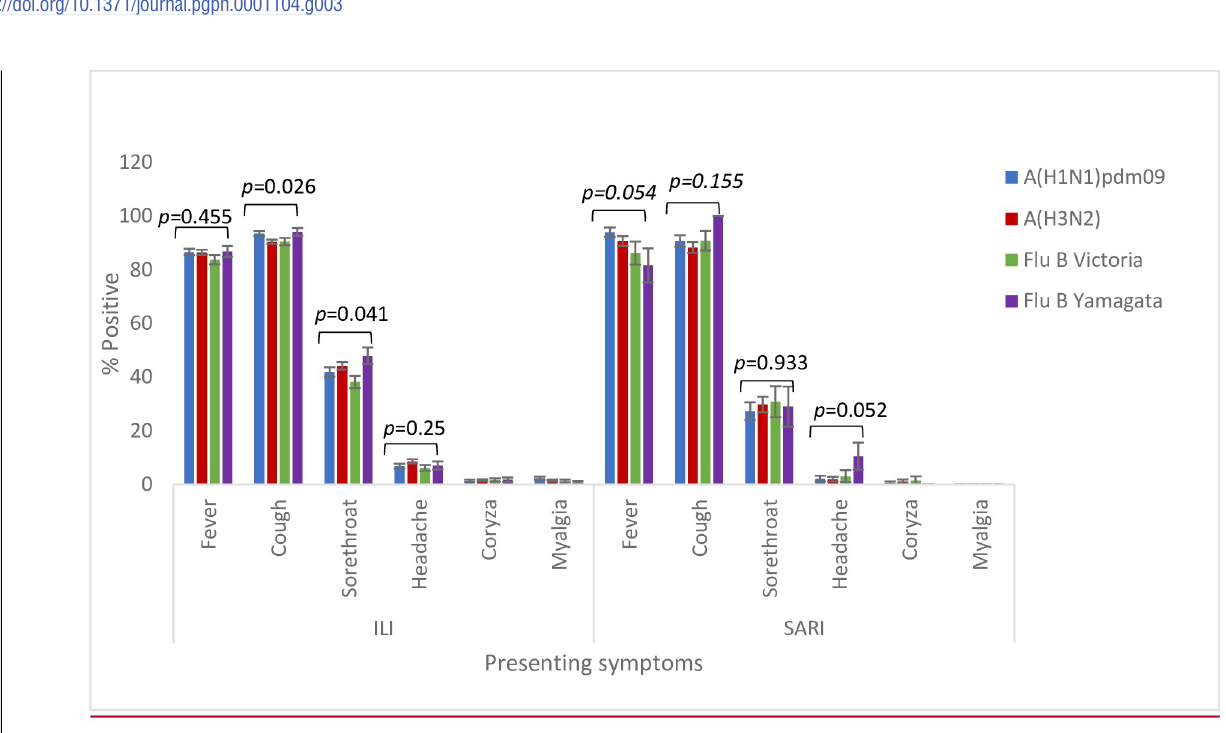
Fig 4. Symptom distribution of ILI and SARI cases based on influenza sub-types in Ghana. � Pearson Chi-square test was used to obtain the p-values.